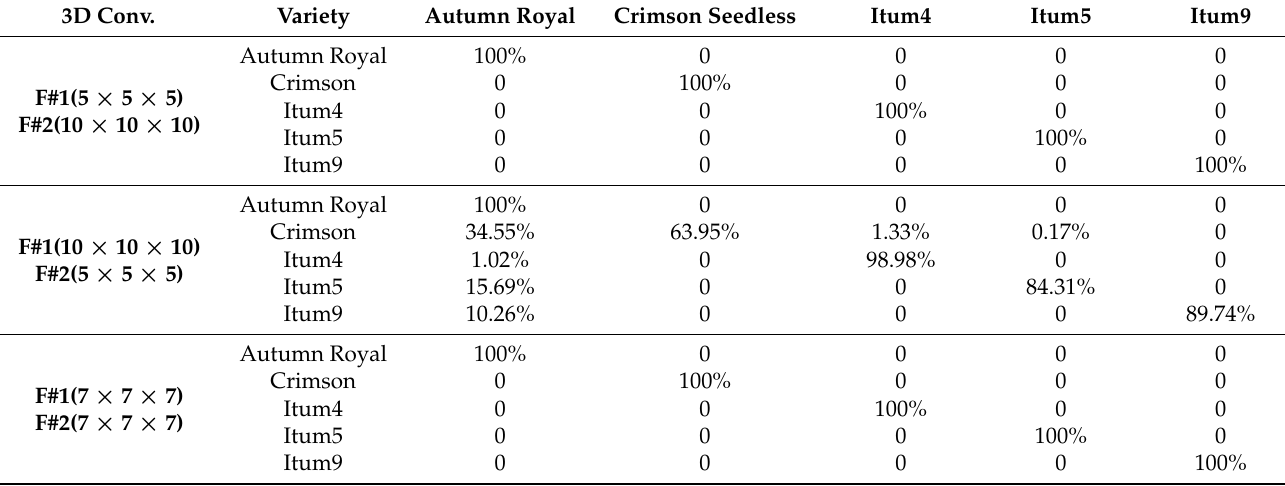
Table 6. Confusion matrix for the three configurations of the 3D convolution layer in the SBO architecture over test data. 3D Conv.